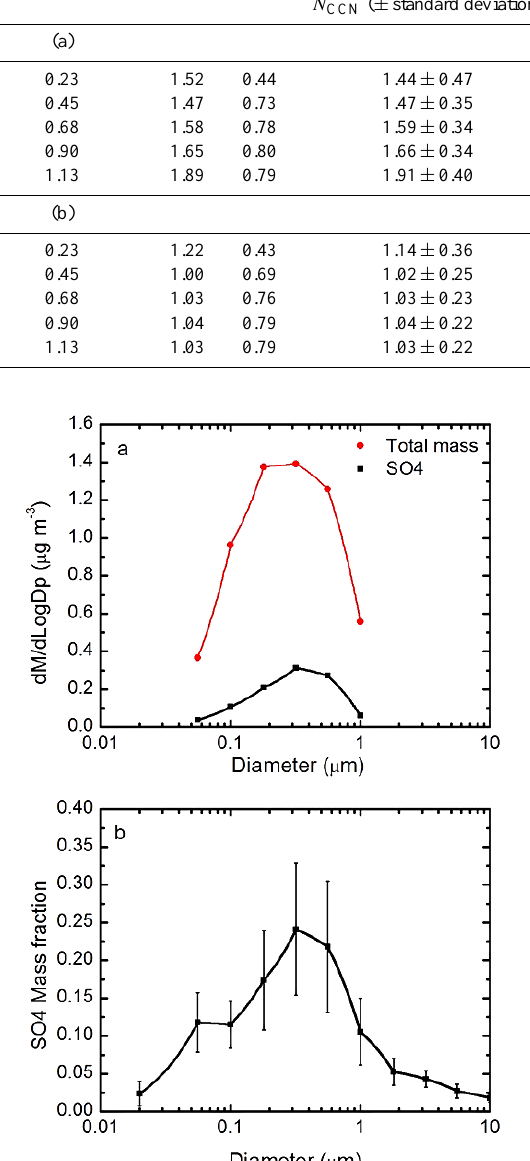
Figure 6. Mean value of (a) d M /d log d (µgm − 3 ) for the period of 15 August to 5 September 2012 and (b) SO 4 mass fraction for the same period. The mass distribution was obtained using MOUDI samples, while the chemical composition was obtained after PIXE analysis. See text for more